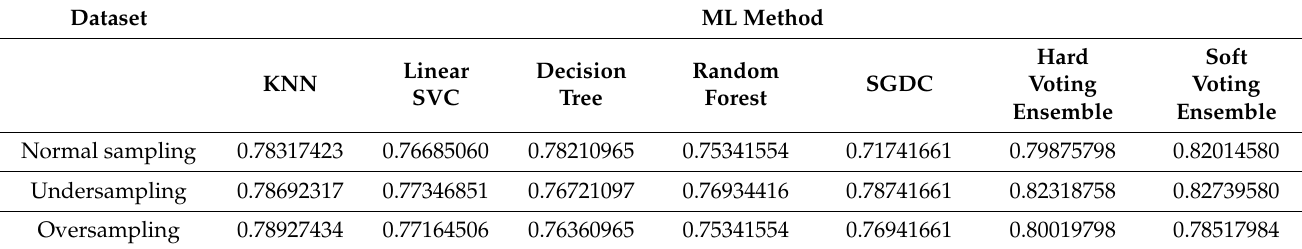
Table 5. Accuracy results for every algorithm and dataset